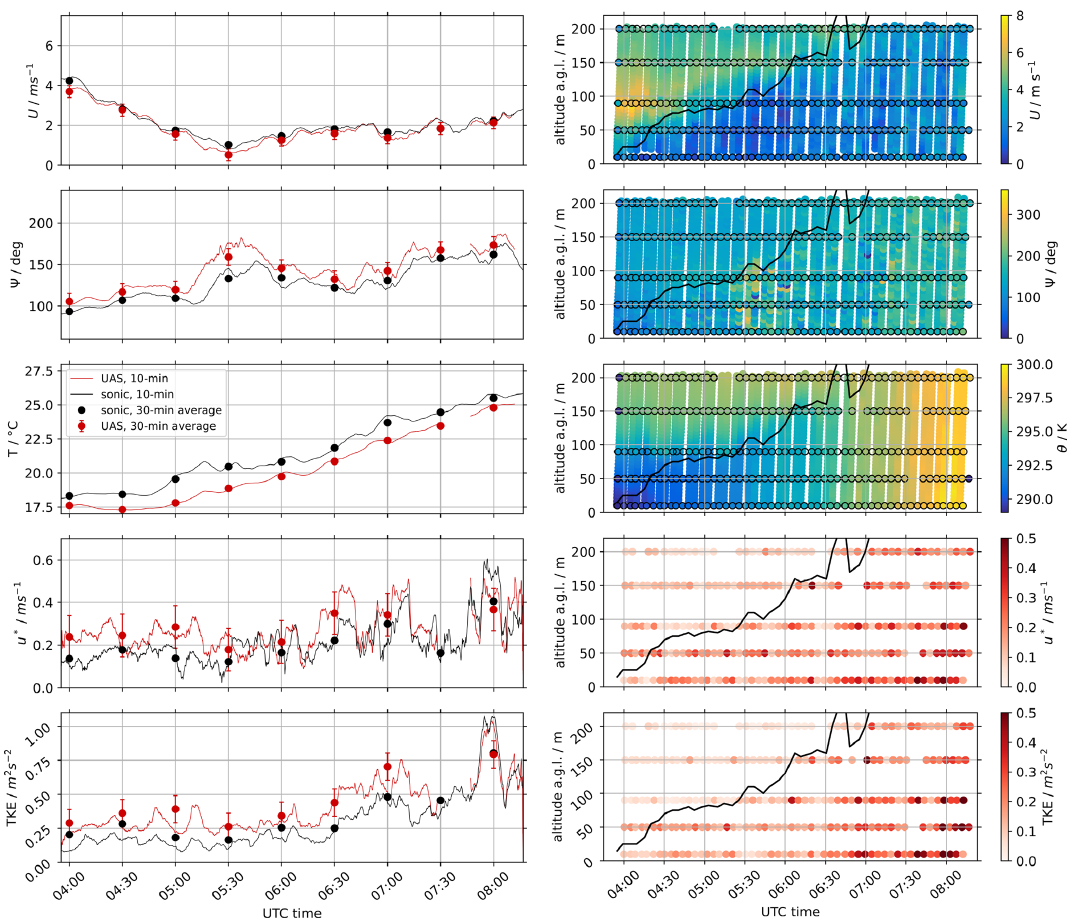
Figure 11. Time series of horizontal wind speed U , wind direction (cid:57) , temperature T , friction velocity u ∗ , and TKE at 50m above ground level during the morning transition of 28 June 2021 in comparison between UAS and sonic anemometers (left). The continuous lines show 10min moving averages, whereas the dots give the 30min mean for each quantity. On the right, Hovmöller diagrams for the observed height range from 10–200m are shown. The black line indicates the height of the mixed layer below the lowest temperature inversion as observed from vertical profiles of potential temperature θ . For wind speed U , wind direction (cid:57) , and θ , continuous ascent vertical profiles from a single drone are shown in the background of the measurements from the hovering UAS at 10, 50, 90, 150, and 200m.